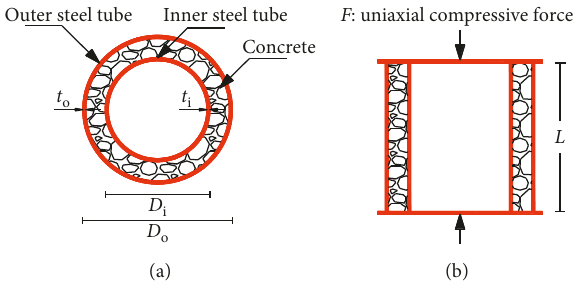
Figure 2: Specimen details and loading condition of CFDST